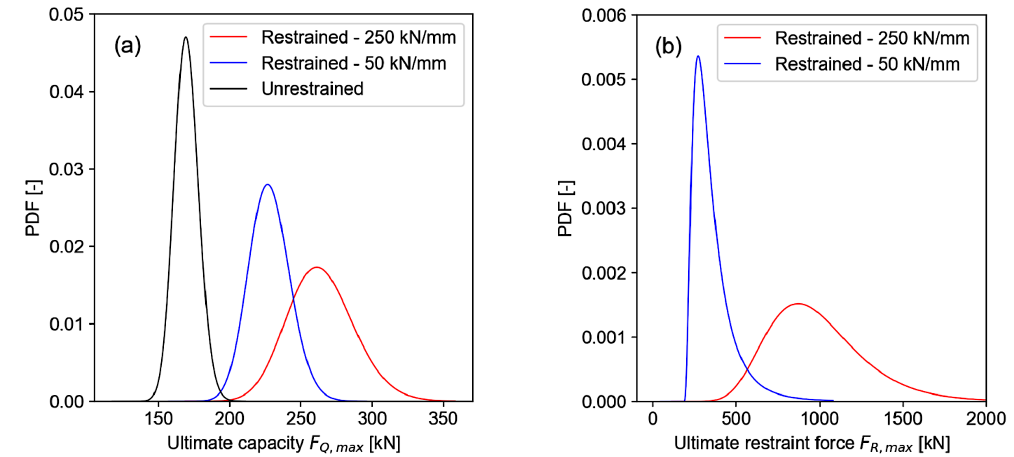
Figure 7. (a) PDF of the ultimate capacity F